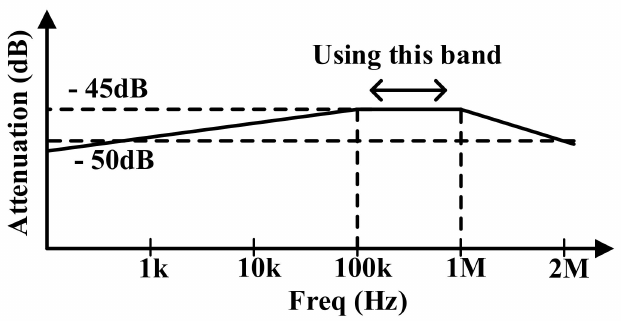
Figure 3. The characteristics of the panel